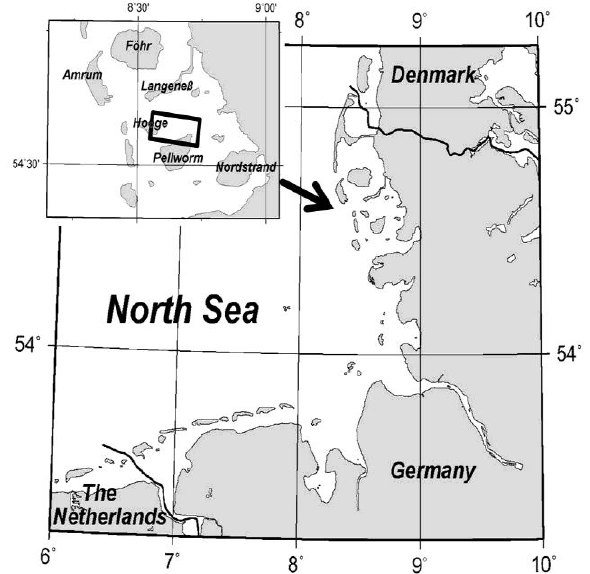
Figure 2. Area of interest on the German North Sea coast. The black rectangle in the close-up on the upper left marks the location of the SAR image shown in Figure 3.